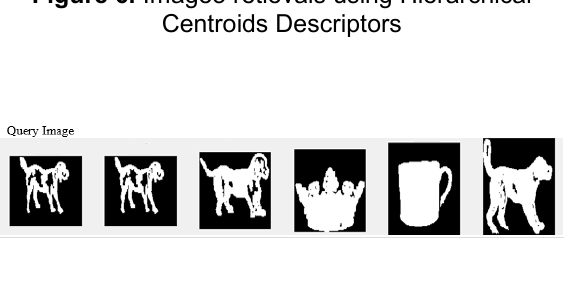
Figure 3. Examples shapes from Kimia99 dataset.